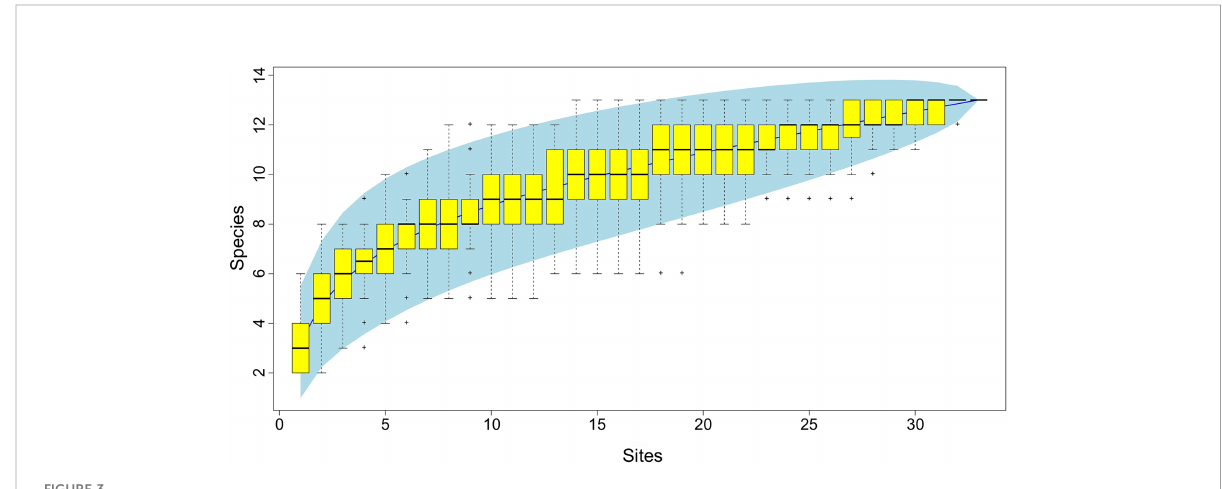
FIGURE 3 Species accumulation curve of arthropods.